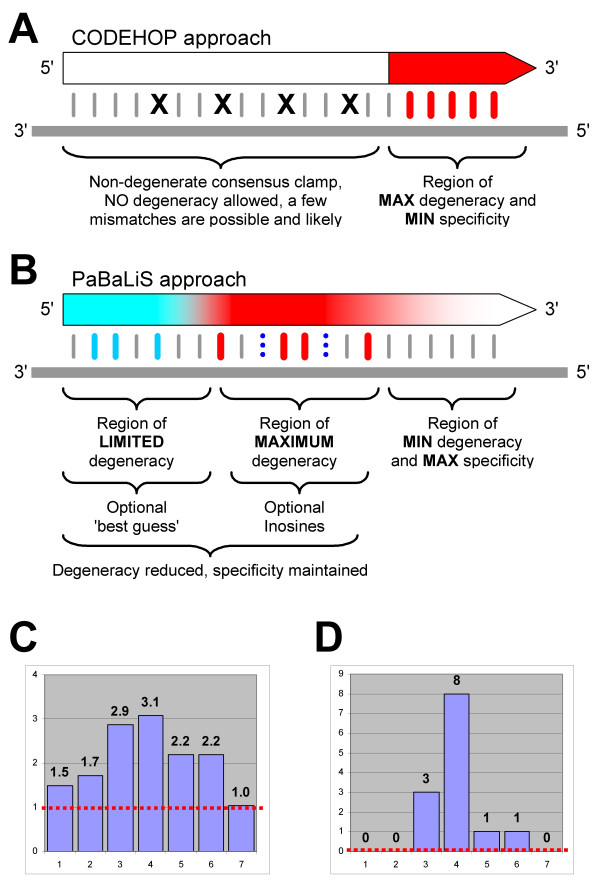
The comparison of CODEHOP and PaBaLiS primers. (A) Schematic representation of the CODEHOP primer, based on the original design by Rose et al. [31]. The maximum degeneracy is aimed at the 3' region, which reduces the amplification efficiency (due to competition by "wrong" 3' end sequences for annealing, these will disallow amplification) and very high probability of dimer formation by such oligos (e.g. fully degenerate 3-4-5 or 6-mers will all able to dimerise). (B) Schematic representation of the PaBaLiS primer design. Note that maximum degeneracy is achieved in the middle of the primer, minimising the number of possible mismatches in the middle of the primer and increasing the stability of the hybrid (primer/cDNA). Low degeneracy (and high sequence conservation) at the 3' end ensured the highest specificity of annealing, amplification and allows to easily avoid primer dimers. (C) The actual distribution of degenerate bases for PaBaLiS primers designed in this study. The choice of oligonucleotides for this analysis includes the 22 oligonucleotides of identical length (20-mer long oligonucleotides, based on 7 amino acid long stretches of partially of fully homologous protein sequences) of the 44 oligonucleotides designed in total. The horizontal axis indicated the nucleotide degeneracy in triplets approximately corresponding to each of the 7 amino acid positions used to generate these 20-mer oligonucleotides. The mean degeneracy calculated as total degeneracy at this position (due to both the amino acid and the genetic code degeneracy) divided by the number of oligonucleotides). The numbers of the bars indicate actual values. Note that decreased overall degeneracy at 5' end is due to the use of "best guess" based and triplets, but not because amino acid degeneracy was lower at this position. (D) The actual distribution of inosine substitutions in the same PaBaLiS primers as in (C). The use of inosines allowed to decrease overall degeneracy without introducing mismatches in the middle of the primers,